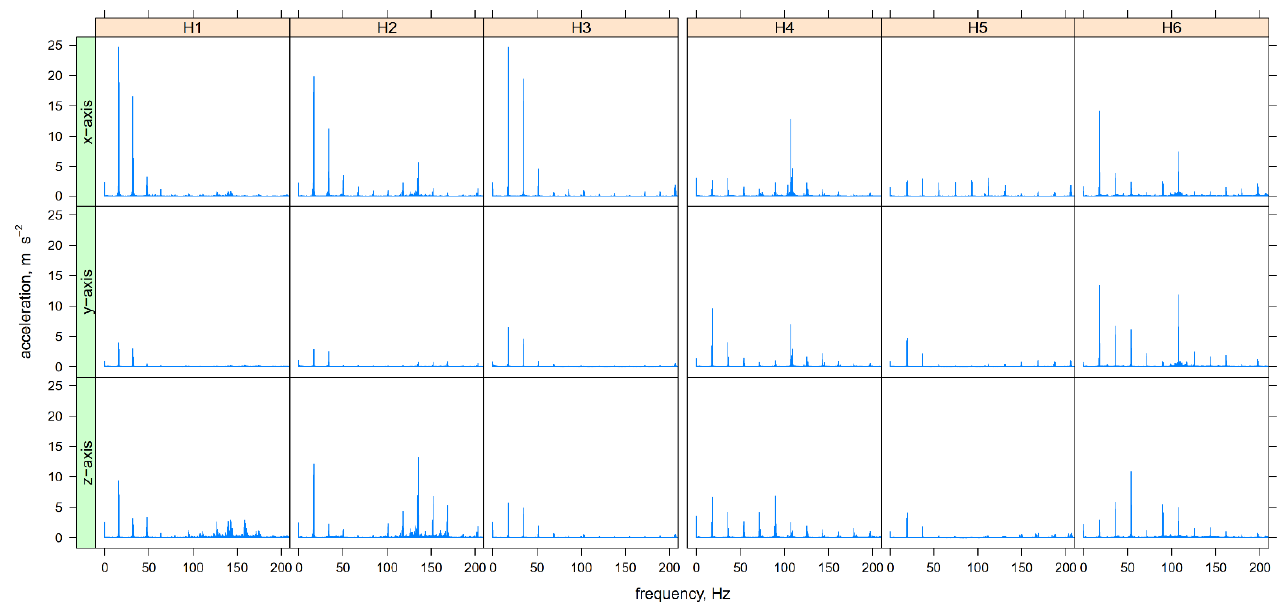
Figure 7. FFT spectra of the harvester heads H1-H6 in front position (M2) and under idling